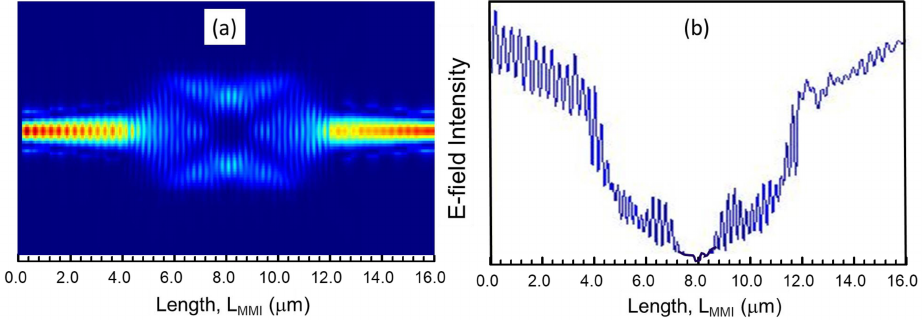
Figure 4. ( a ) Field profile of a MMI 3 phase shifter without a heater. The 4 µ m long tapered access waveguides are connected at both ends of the MMIs to reduce power losses ( b ) Intensity profile of the 1 × 1 MMI 3 phase shifter as a function of L MMI . 3